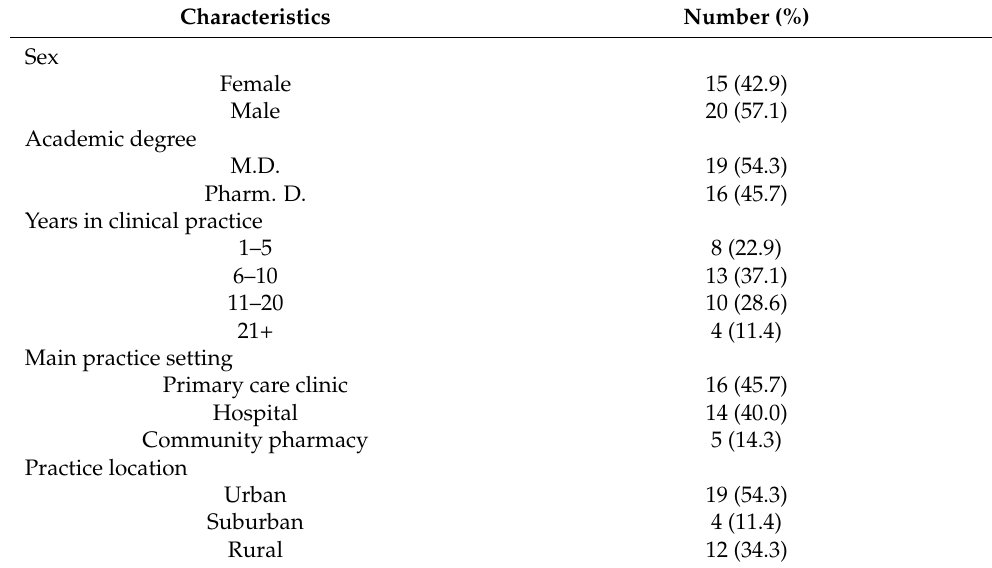
Table 1. Participant characteristics (N =